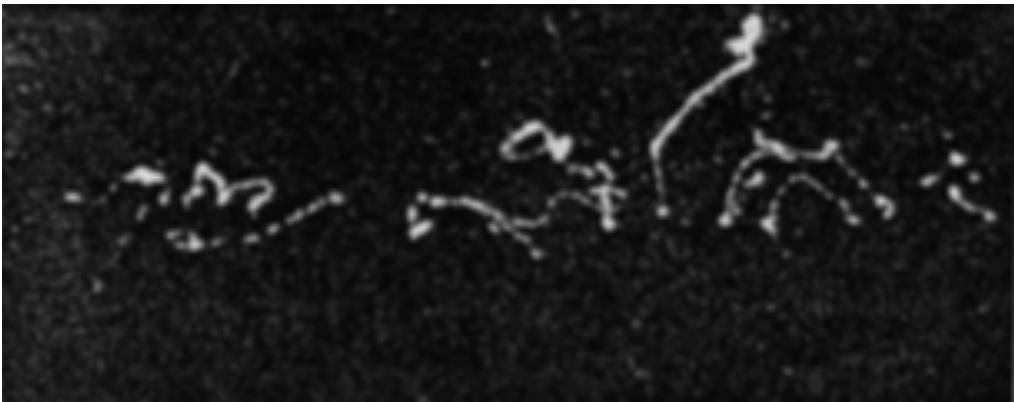
Figure 1. A cloud chamber image from the paper by M. Pierre Auger in 1925. The picture